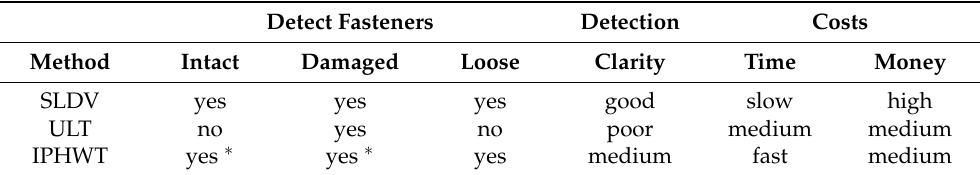
Table 1. This table summarizes the key aspects for each individual inspection technique as well as the respective detection clarity and cost in time and money. ∗ As described before, IPHWT detects intact and damaged rivets but does not enable the distinction between the two. Detect Fasteners Detection Costs Method Intact Damaged Loose Clarity Time Money